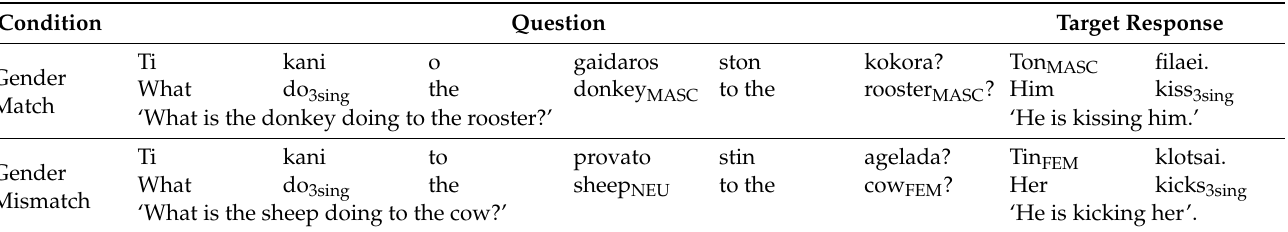
Table 6. Design of the production